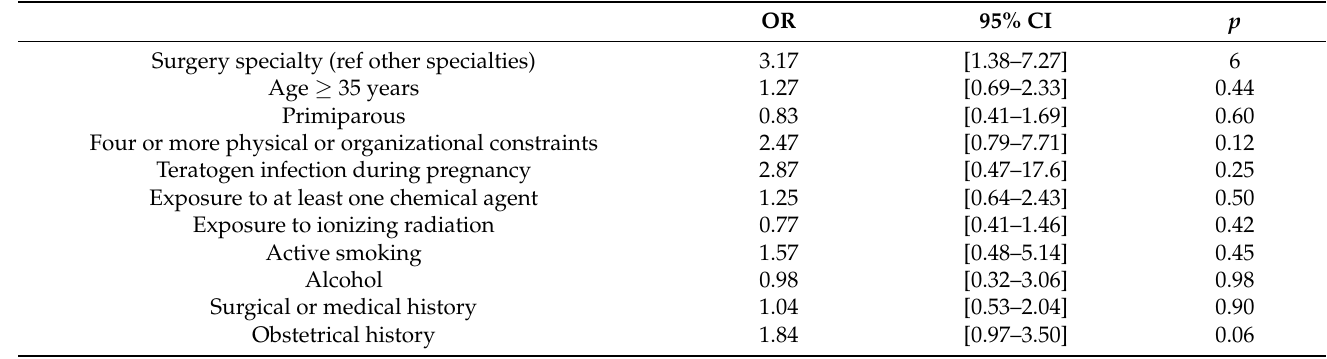
Table 3. Risk of pregnancy complications for female surgeons relative to women in other medical specialties—univariate logistic regression